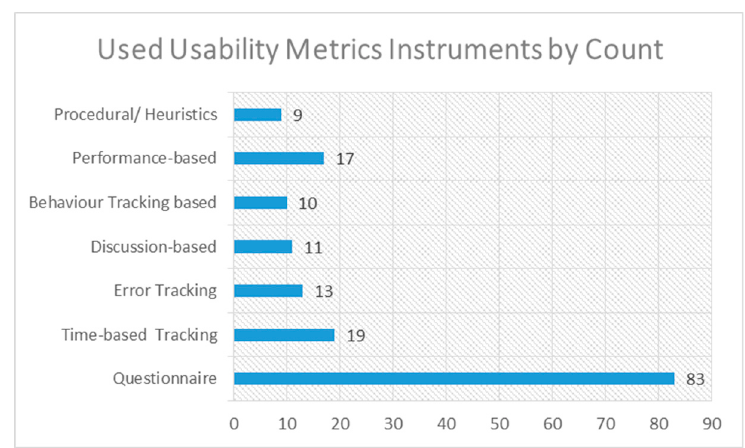
Figure 5. Used usability metrics instruments by count.